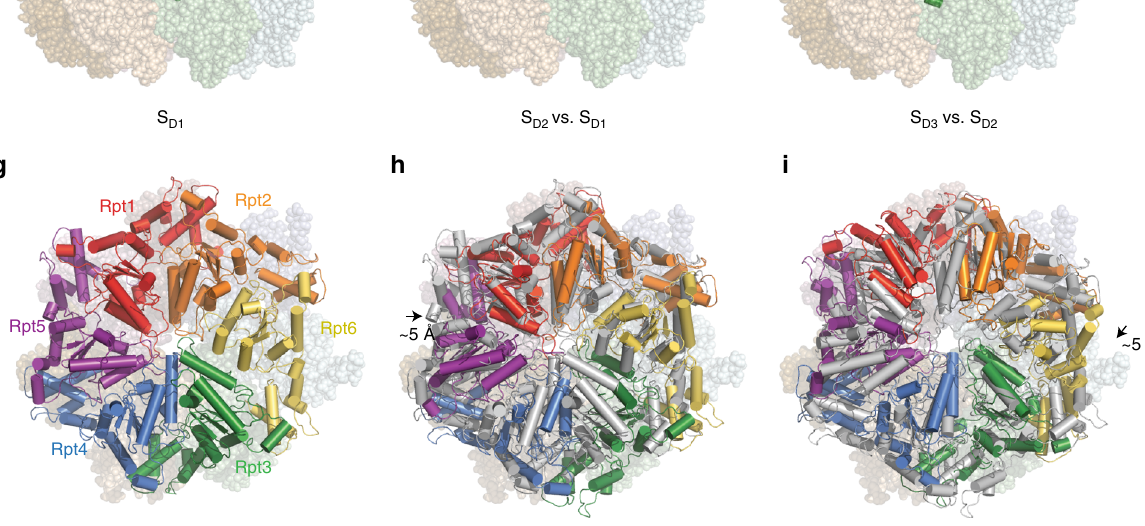
Fig. 3 Conformational changes of the ATP- γ -S-bound RP in three different S D -like states. a Top view of the lid in S D1 . b , c Top view of the lid in S D2 ( b ) and S D3 ( c ) superimposed over the transparent cartoons of S D1 and S D2 , respectively. d Side view of the ATPase ring above the α -ring in S D1 . e , f Side view of the ATPase ring above the α -ring in S D2 ( e ) and S D3 ( f ) superimposed with the transparent gray cartoons of S D1 and S D2 , respectively. g Top view of the ATPase ring in S D1 . h , i Top view of the ATPase ring in S D2 ( h ) and S D3 ( i ) superimposed over the gray cartoons of S D1 and S D2 ,